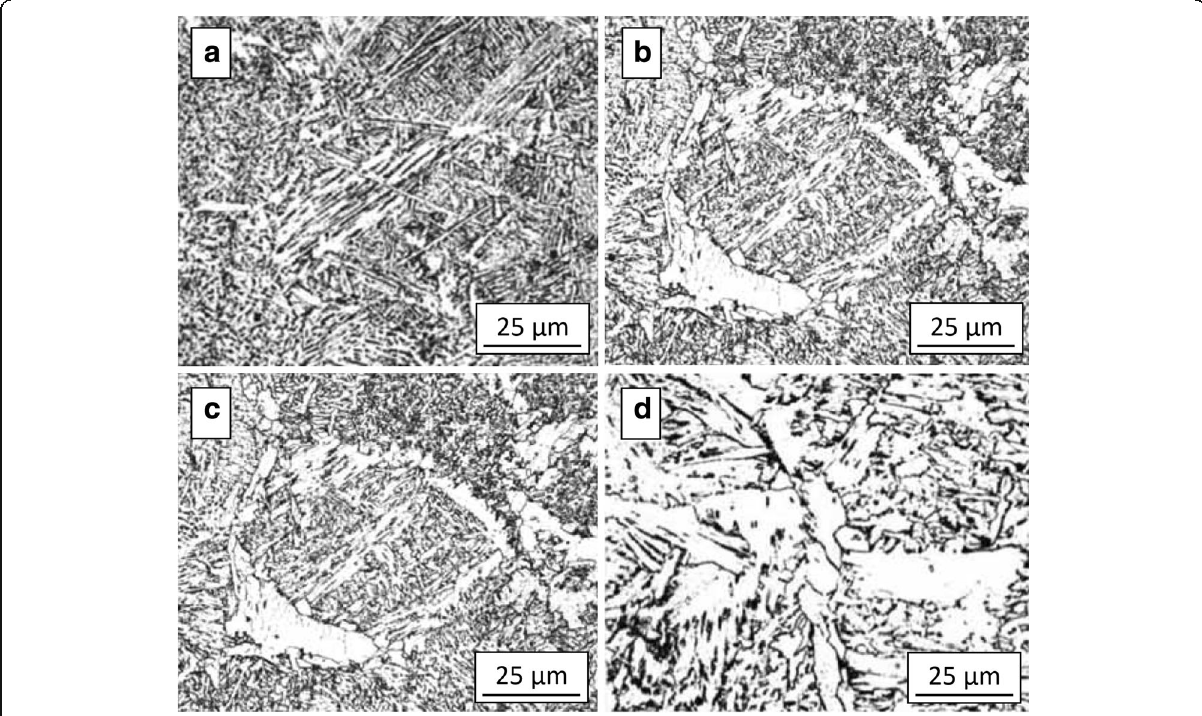
Fig. 2 The microstructure of 09G2FB in various regions of HAZ. a Fusion line with welding heat input 1.5 kJ/mm. b Fusion line with welding heat input 5 kJ/mm. c CGHAZ region with welding heat input 1.5 kJ/mm. d CGHAZ region with welding heat input 5